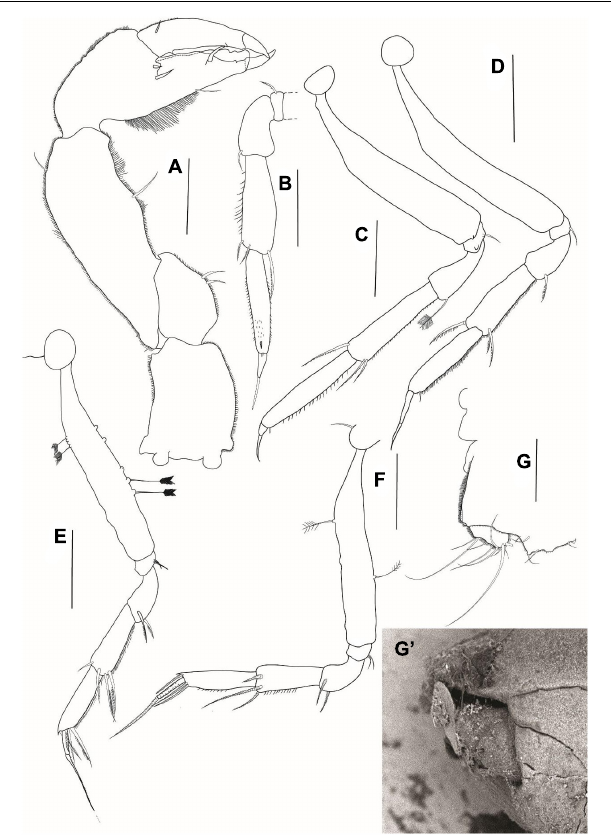
FIGURE 4 | Agathotanais beatae n. sp., neuter, holotype (ZMH-K-61146). (A) cheliped; (B) pereopod-1; (C) pereopod-2; (D) pereopod-3; (E) peropod-5; (F) peropod-6; (G) uropod; (G’) detail of uropod (SEM image). Scale bar: (A–G) = 100 µ m.